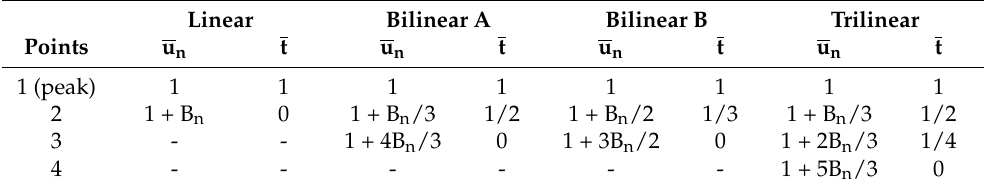
Figure 6. Approximation of exponential curve by 4 segmented curves with equal fracture energy. Table 1. Definition of the piecewise linear post-peak weakening curves in Figure 6. Linear